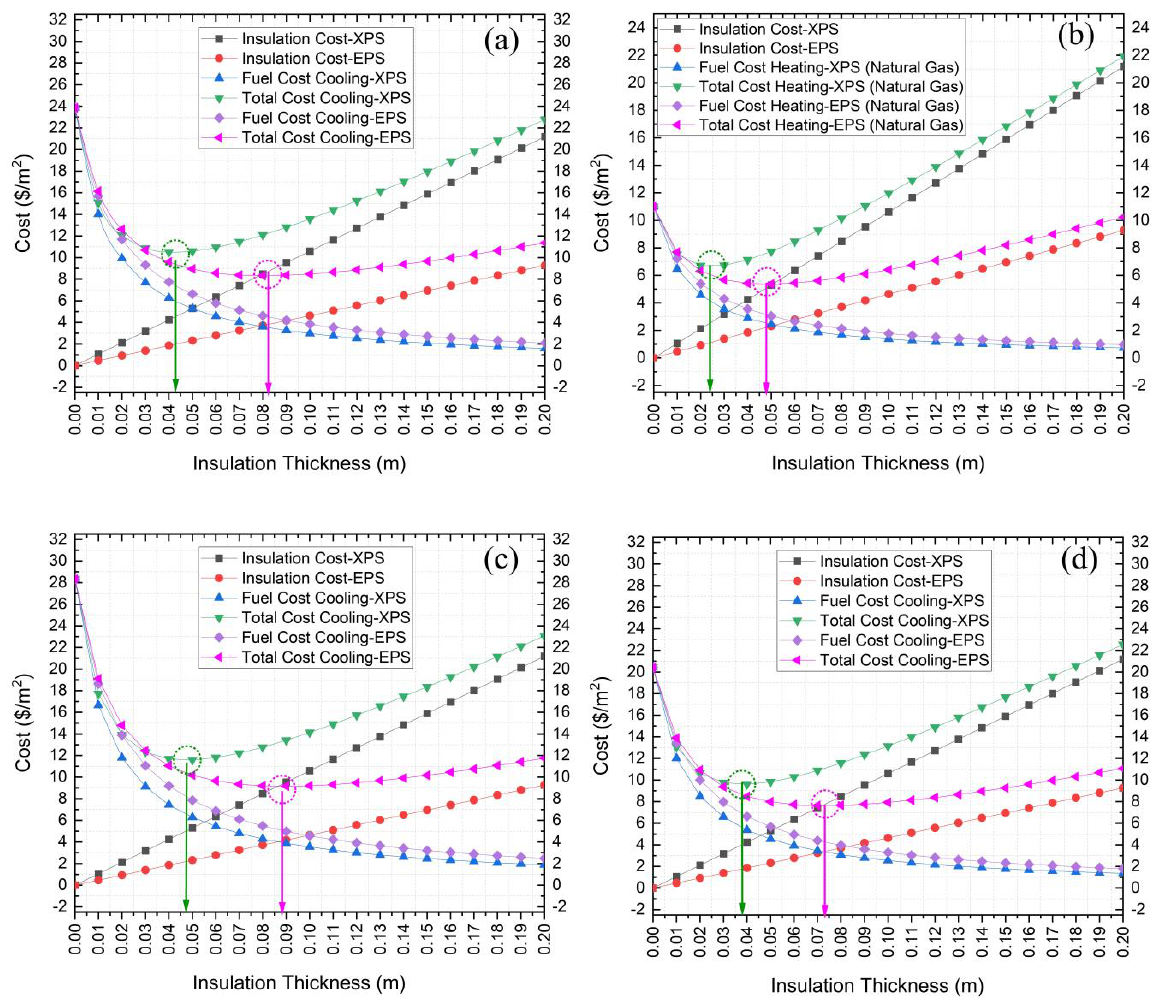
Figure 3. Cost–insulation thickness relationship for EPS and XPS insulation materials: ( a ) Mumbai, ( b ) Srinigar, ( c ) Chennai, and ( d ) Patna.